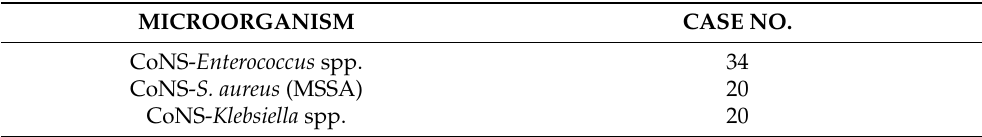
Table 6. Frequently identified bi-microbial